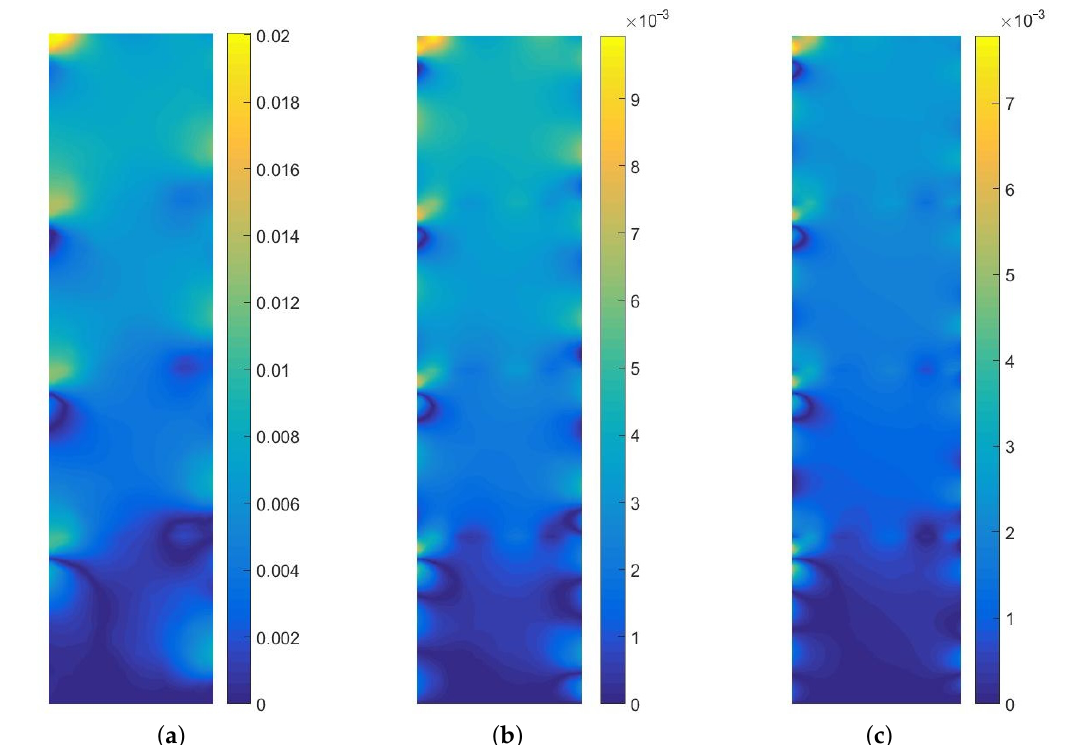
Figure 12. Error distribution for the increasing approximation order: ( a ) p = 1, ( b ) p = 3, ( c ) p = 5,